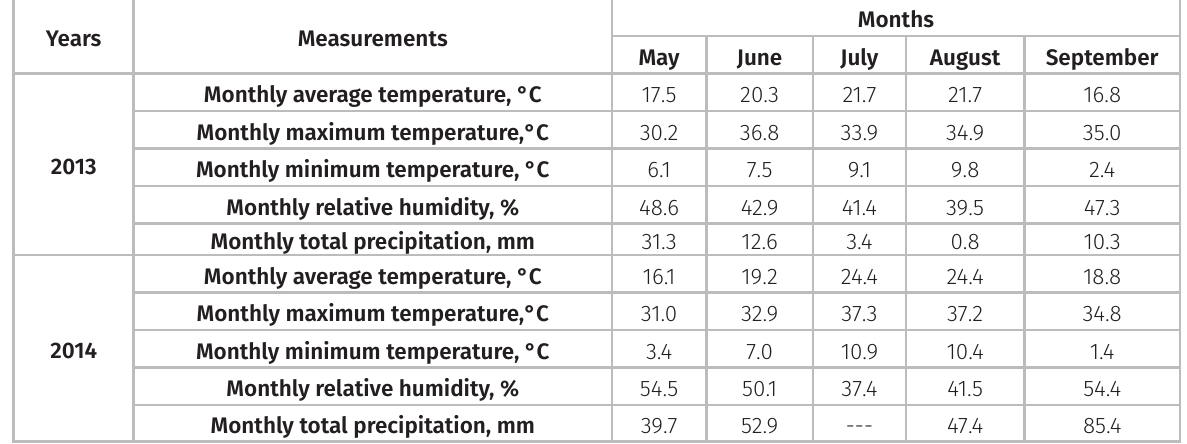
Table I. Precipitation, temperature and relative humidity values of the years 2013 and 2014. Years